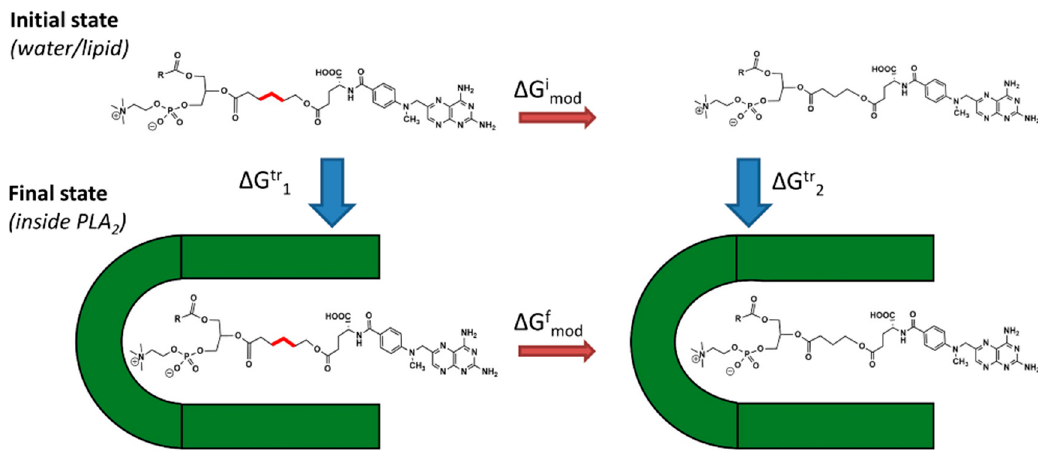
Figure 2. Diagram of the thermodynamic cycle used to compute the relative binding energies of PL-methotrexate molecules in the transition state complex of PLA 2 . ∆𝐺 (cid:3040)(cid:3042)(cid:3031)(cid:3033) and ∆𝐺 (cid:3040)(cid:3042)(cid:3031)(cid:3036) are free energies of adding or removing of -CH 2 units in the initial and final states; ∆ G tr 1 and ∆ G tr 2 are the binding free energies of the prodrug molecules in the transition state geometry of PLA 2 .